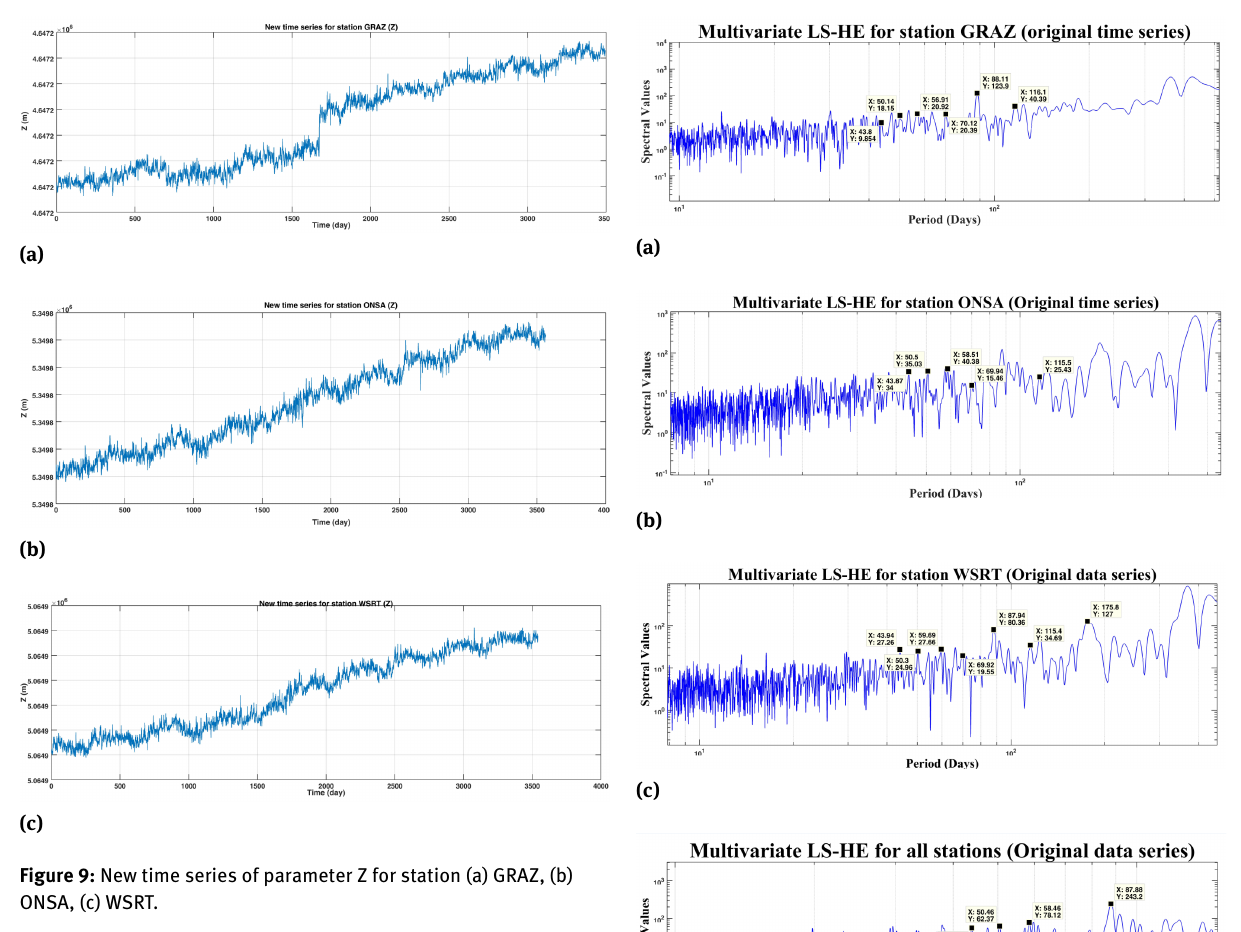
Figure 9: New time series of parameter Z for station (a) GRAZ, (b) ONSA, (c) WSRT.